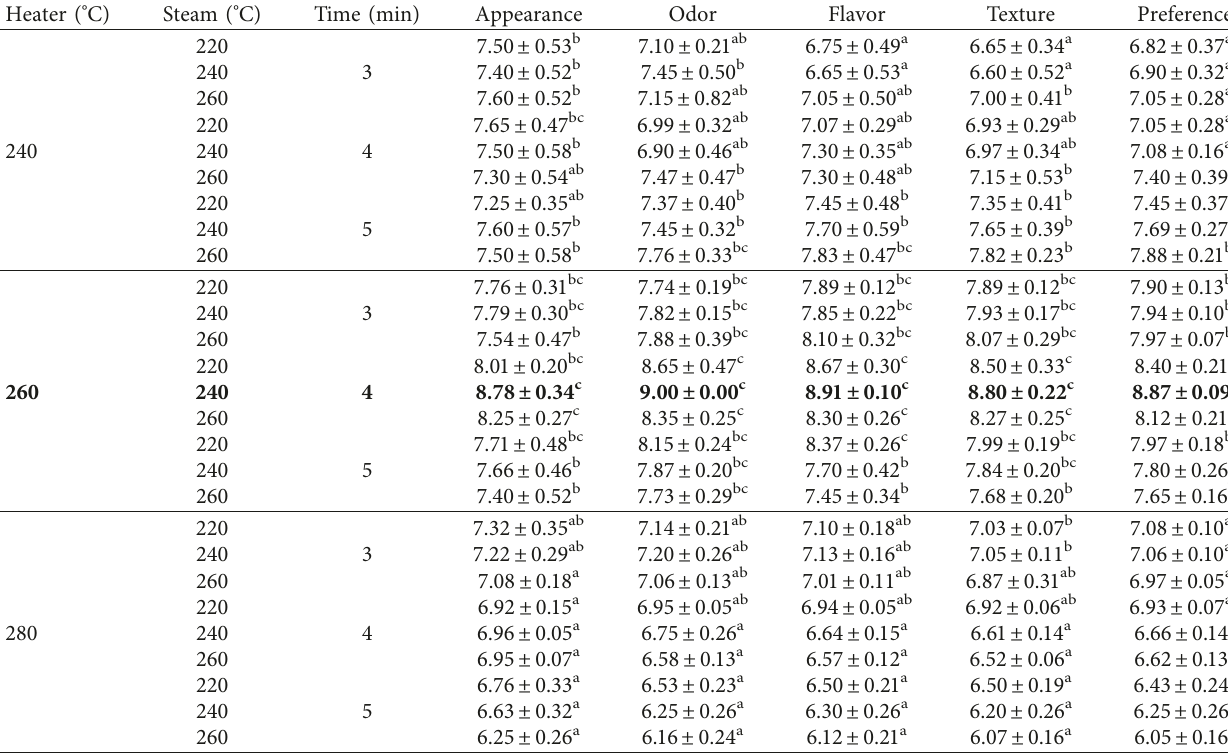
Table 3: Sensory evaluation of superheated steam-treated squid.